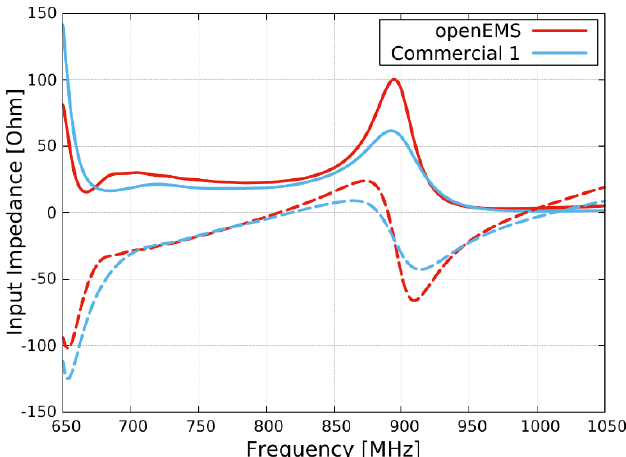
Fig. 3. Feeding point impedance of the three-element printed log-periodic antenna [33]. Red line: OpenEMS; Blue line: commercial code 1.